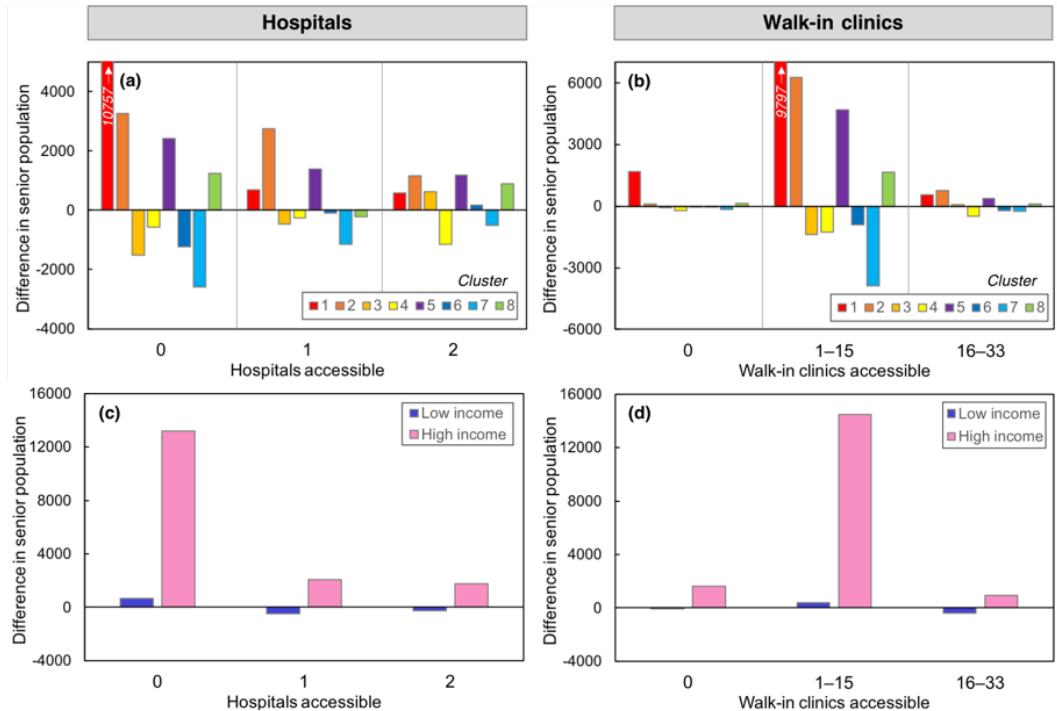
Figure 5. Difference (from 2016 – 2022) in the number of seniors with access to zero, up to half and up to all facilities, for ( a ) hospitals (all clusters), ( b ) walk-in clinics (all clusters), ( c ) hospitals (low vs. high income clusters) and ( d ) walk-in clinics (low vs. high income clusters). Vertical axes are curtailed to improve readability of graphs.